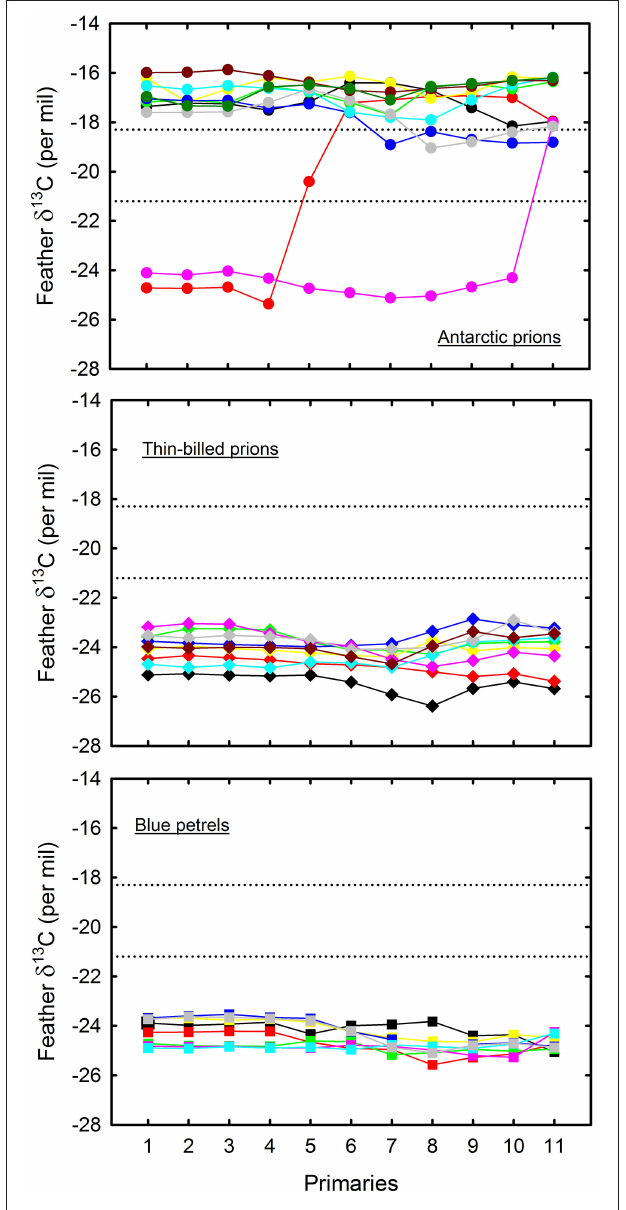
FIGURE 6 | Primary feather δ 13 C − and δ 15 N-values of blue petrels (lower panel) and of thin-billed (mid-panel) and Antarctic (upper panel) prions. Each color indicates an individual. Feathers were collected from dead birds. Numbering refers to the tip of each of the 10 primaries from the innermost (P1) to the outermost (P10) feather; 11 refers to the base of P10 and hence to the very end of primary molt. Lower and upper control lines refer to the estimated δ 13 C location of the Polar Front and Subtropical Front, respectively (Jaeger et al.,